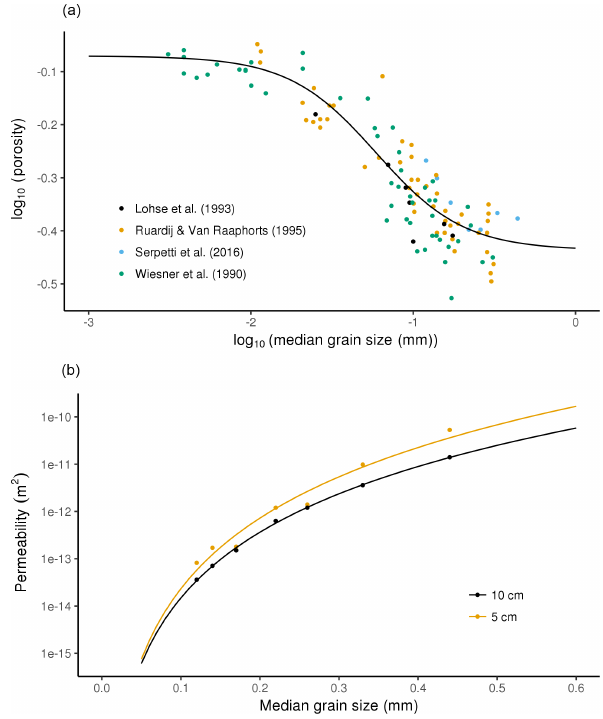
Figure 4. (a) Assembled data on sediment porosity and median grain size (filled circles) and the fitted relationship (solid line). (b) Annual average permeability m − 2 of sediments from seven sites off the north-east coast of Scotland; data from Serpetti et al. (2016).